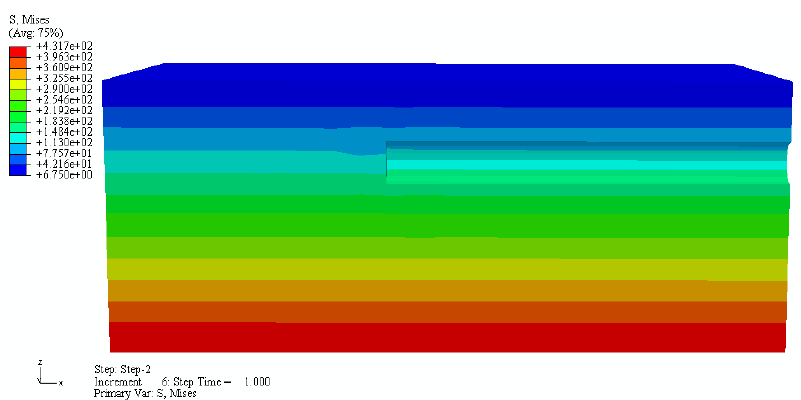
Figure 12. von Mises stress clouds of the model under additional thrust action (kPa).